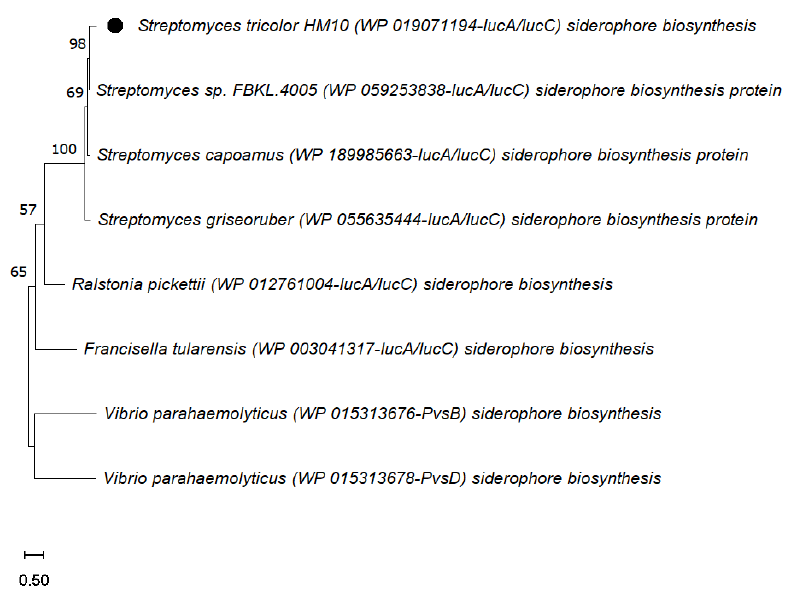
Figure 8. Molecular phylogenetic analysis of IucA/IucC family protein in the carboxylate pathway compared with seven protein sequences from other bacteria. The dendrogram was generated by the maximum likelihood, Jones–Taylor–Thornton (JTT) model, and nearest-neighbor-interchange (NNI) with 1000 bootstrap replicates (see the Methods section). The accession numbers of the SidC FASTA sequences are given.